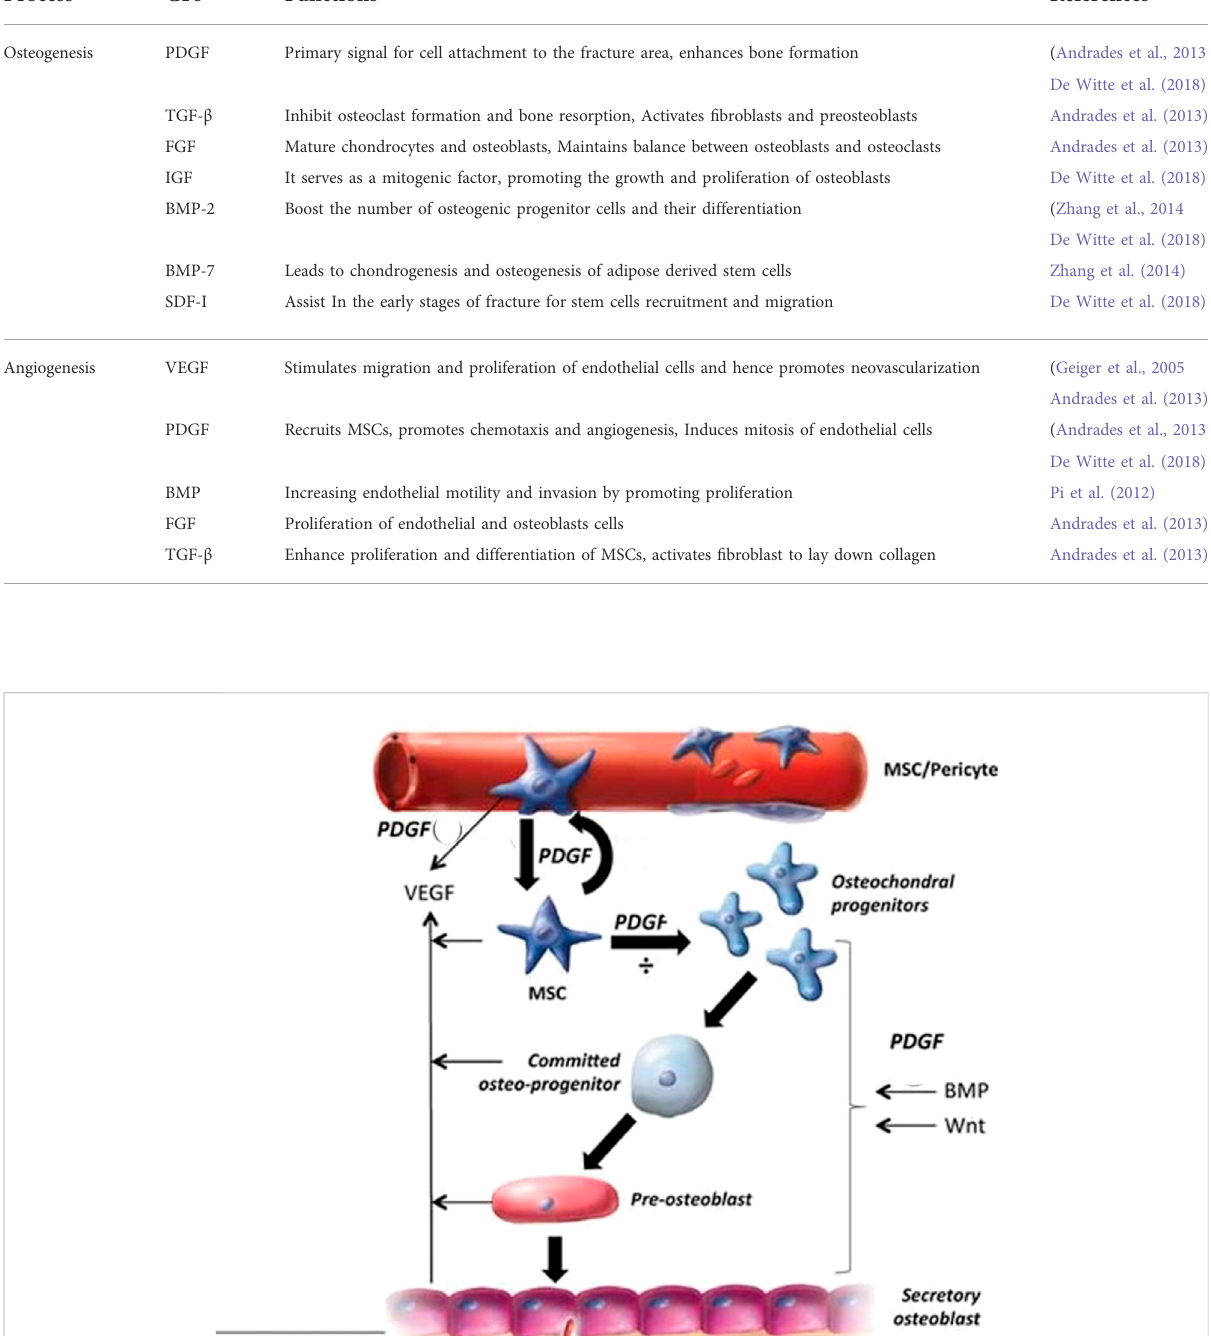
Frontiers in Bioengineering and